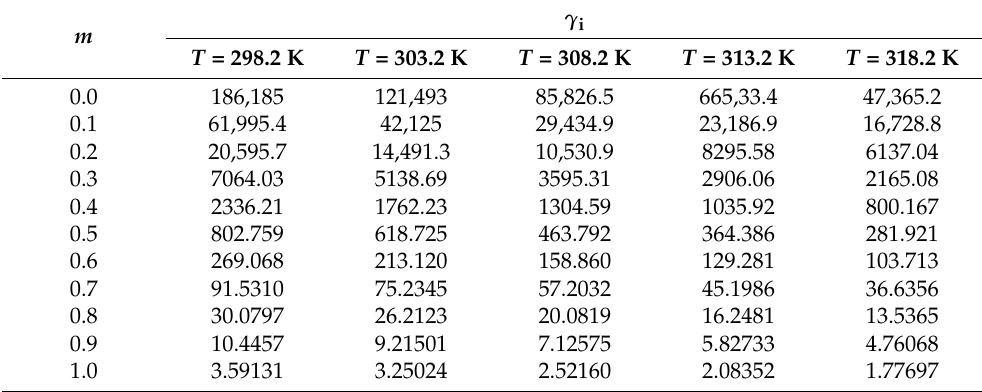
Table 4. Activity coefficients ( γ i ) of FXT in different {PEG 400 (1) + H 2 O (2)} mixtures at 298.2–318.2